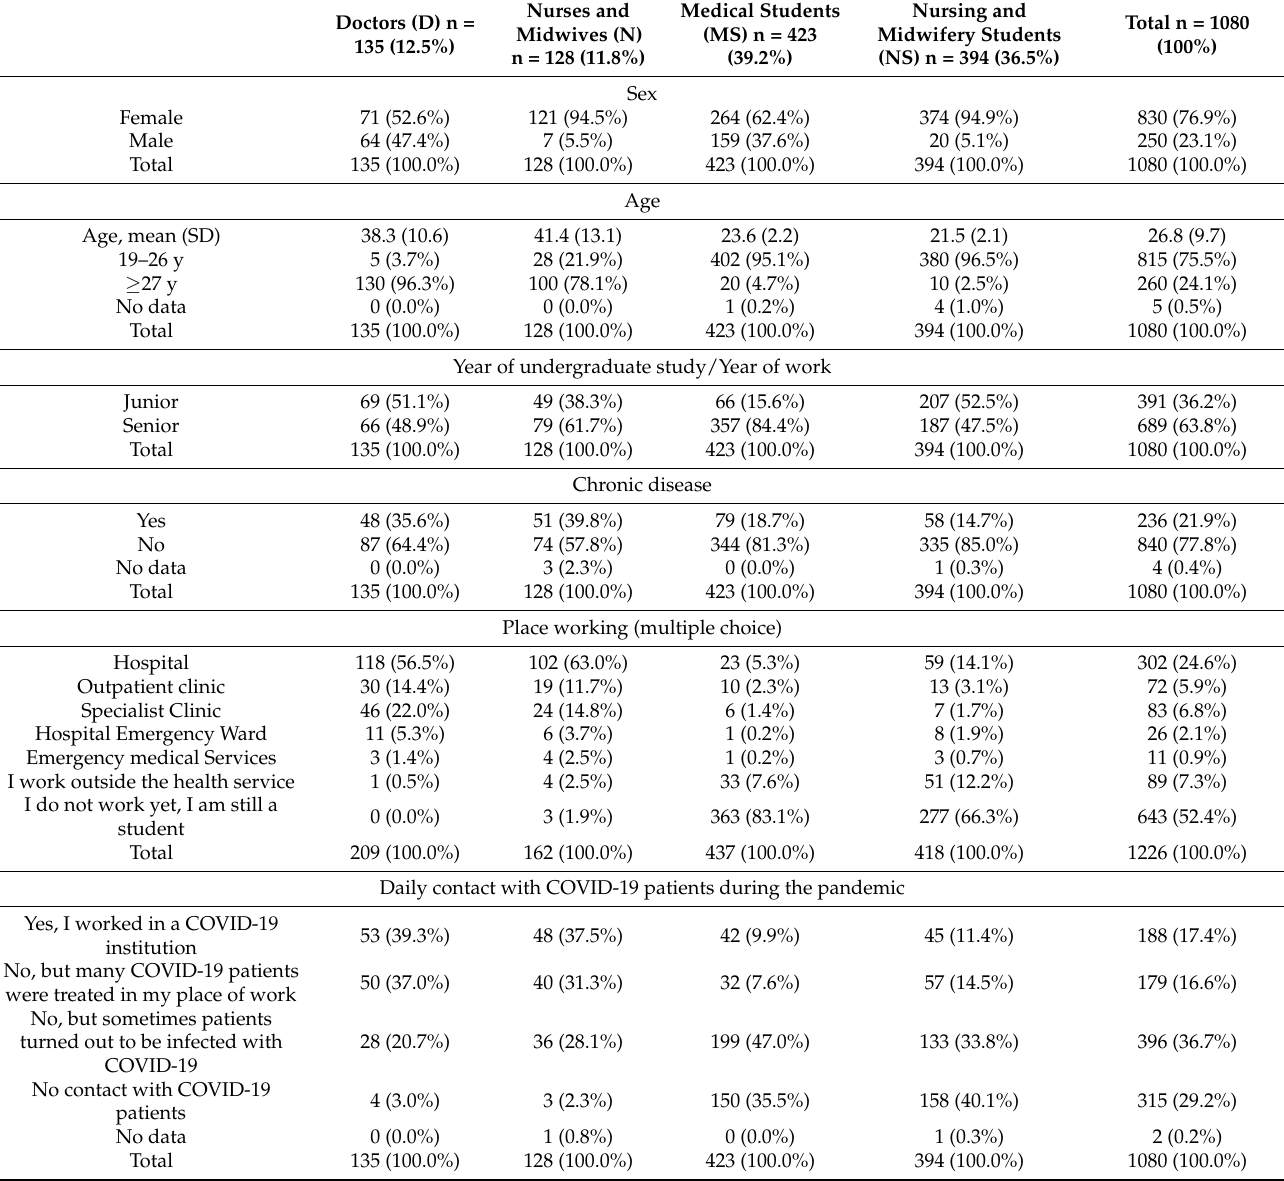
Table 1. Socio-demographics characteristics of respondents in four healthcare worker